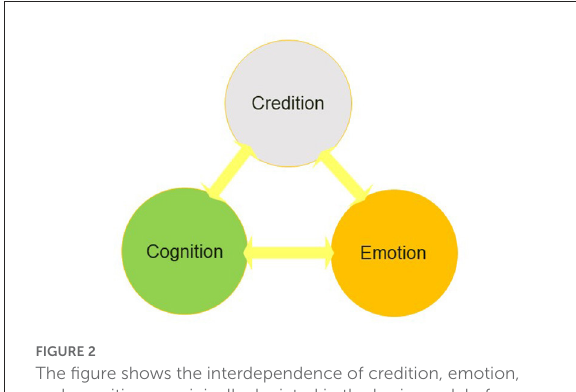
FIGURE2 The figure shows the interdependence of credition, emotion, and cognition as originally depicted in the basic model of credition. [ © HF